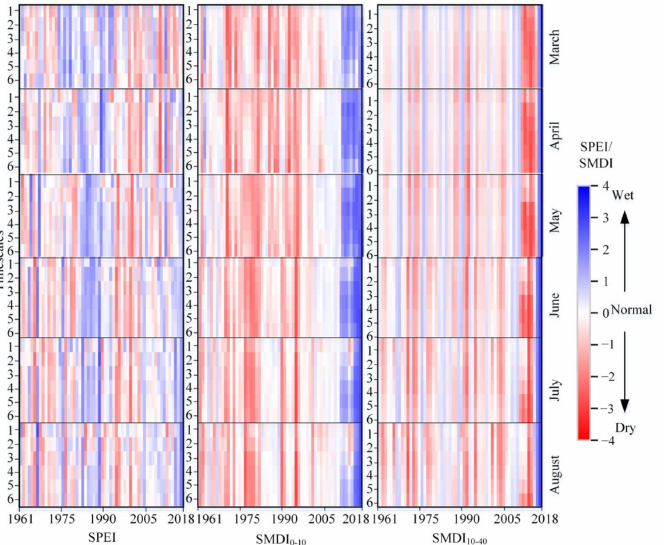
Figure 4. Temporal variations of the monthly SPEI, SMDI 0–10 and SMDI 10–40 at the 1- to 6-month timescales during the growing seasons of spring wheat at the Gonghe